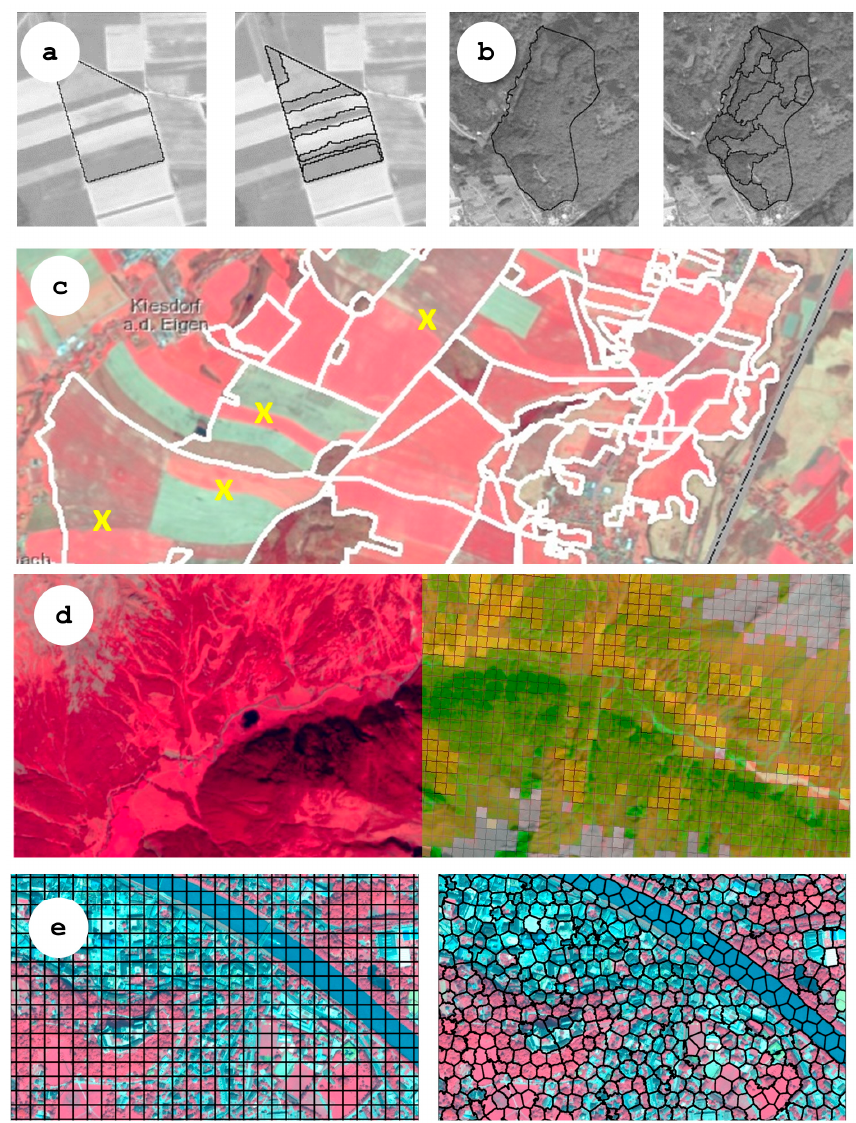
Figure 6. Spatial constraints, SDI integration and information update. ( a ) Cadastre boundaries mark the outlines of an agricultural property, which consists of several fields, whose boundaries are added by region-based segmentation, ( b ) outlines are constrained by the digital cadastre. ( c ) Overlay of ATKIS vegetation layer with recent Sentinel 2 scene from eastern Germany close to the Polish boundary. ( d ) Scene classification map of a Sentinel-2 image of the Austrian alps (left), as derived by the SIAM® pre-classification software [81] , calculated and overlaid on a 100m ETRS grid (right). ( e ) The Europe-wide ETRS grid (50 m) provides grid spacing centroids for SLICO superpixel generation based on QuickBird imagery of the old town of Salzburg, Austria.